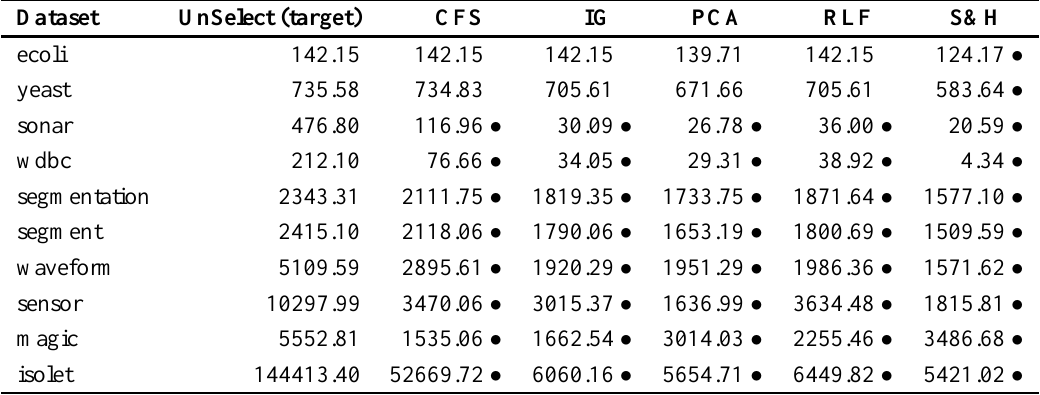
Table 2. Squared errors for feature selected SimpleKMeans (the fewer, the better).